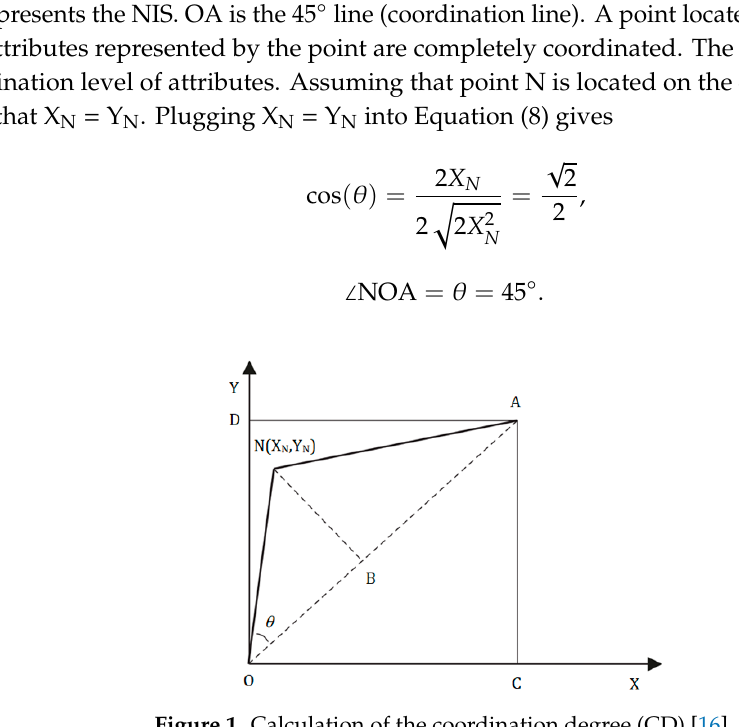
Figure 1. Calculation of the coordination degree (CD)